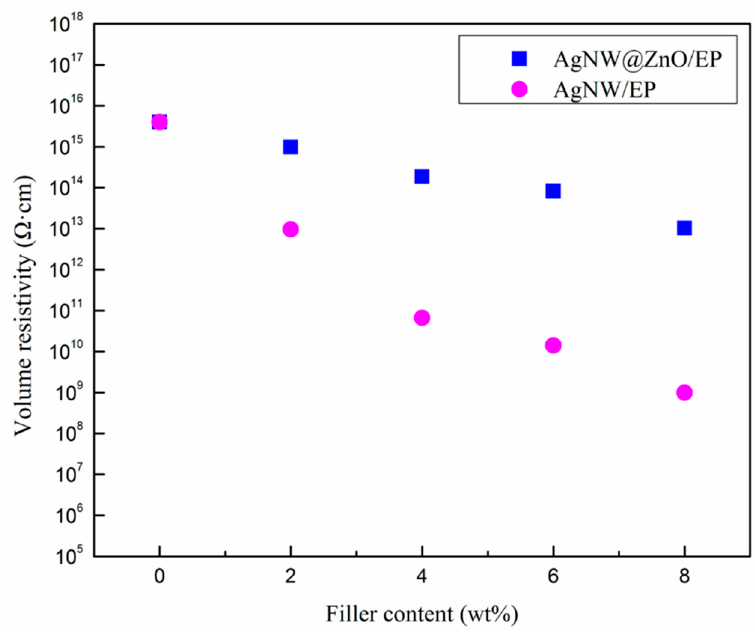
Figure 8. Volume resistivities of AgNW@ZnO/EP and AgNW/EP composites.